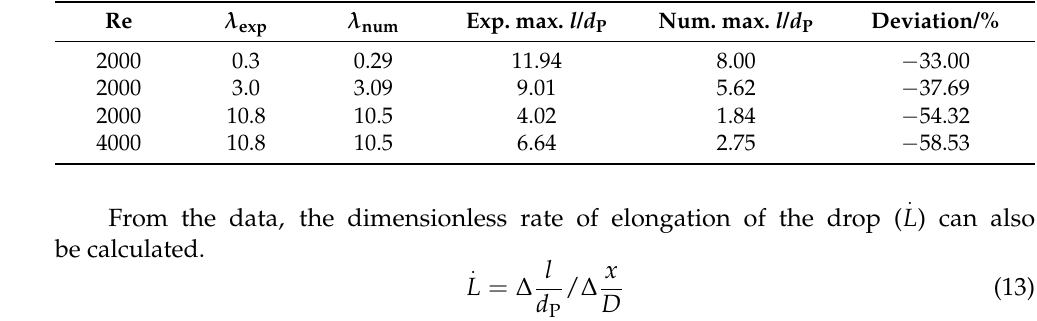
Figure 19. Dimensionless elongation curves for different initial drop diameters ( 𝑑 (cid:2900) ) at 𝜆 (cid:3404) 3.0 and 𝑅𝑒 (cid:3404) 2000 . 4. Discussion The investigations show that the elongation of the primary droplets at constant Reyn ‐ olds number in the laminar inlet area increases with decreasing viscosity ratio starting